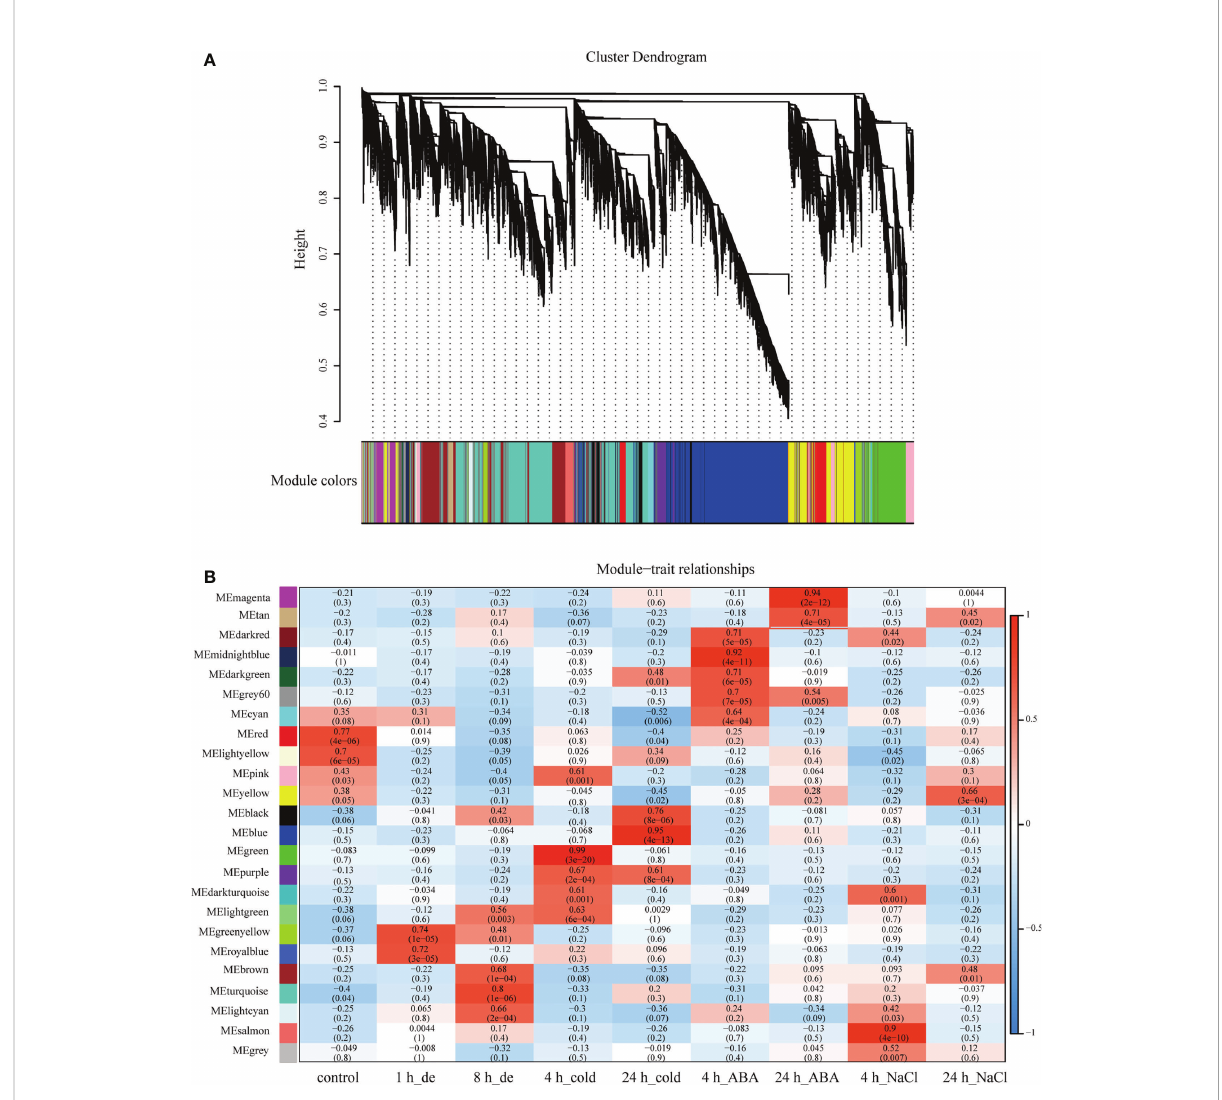
FIGURE 3 Co-expression network generation on isoform level by WGCNA. (A) Hierarchical cluster tree showing co-expression modules identi fi ed by WGCNA. Each leaf in the tree represents one isoform. The major tree branches constitute 23 modules, labeled with different colors. (B) Heatmap of correlation between modules and treatments. Each row corresponds to a module, labeled with a color as in panel (A)